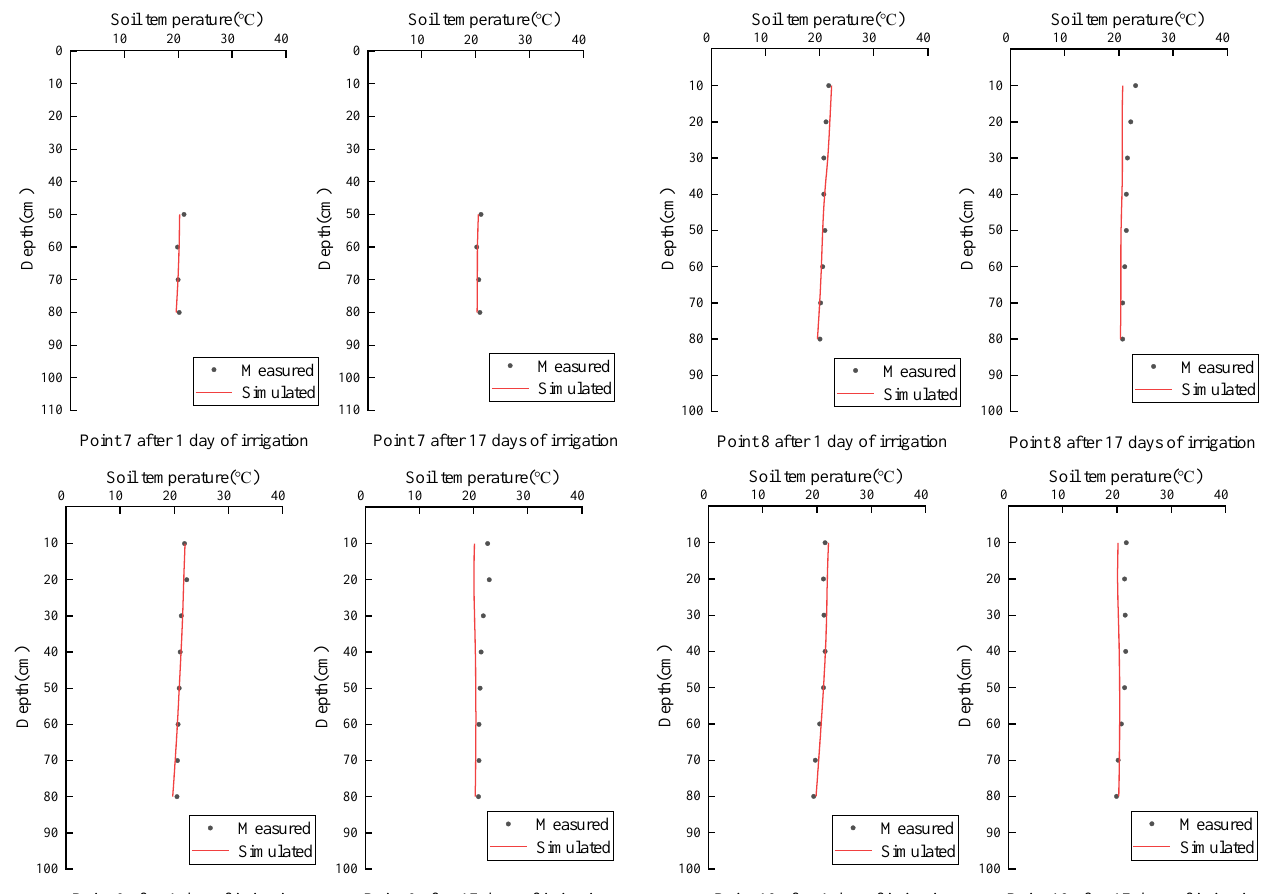
Figure 8. Measured and simulated values of soil temperature at different times and profiles.